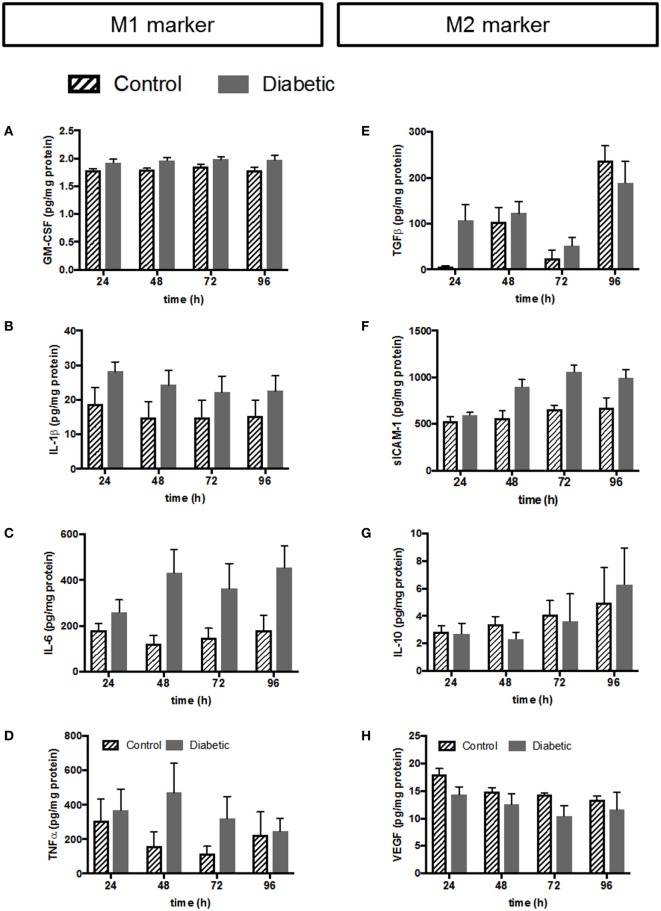
Validation of selected cytokines and growth factors from multiplex by conventional ELISA. Left panel: cytokines associated with the M1 phenotype; (A) ELISA against GM-CSF. (B) ELISA against IL-1β. (C) ELISA against IL-6. (D) ELISA against TNFα. Right panel: cytokines and growth factors associated with the M2 phenotype; (E) ELISA against TGFβ. (F) ELISA against sICAM-1. (G) ELISA against IL-10. (H) ELISA against VEGF. Pooled data: n = 5 control HBCs, n = 6 GDM HBCs, Kruskal–Wallis test (ANOVA on ranks), mean±SEM.